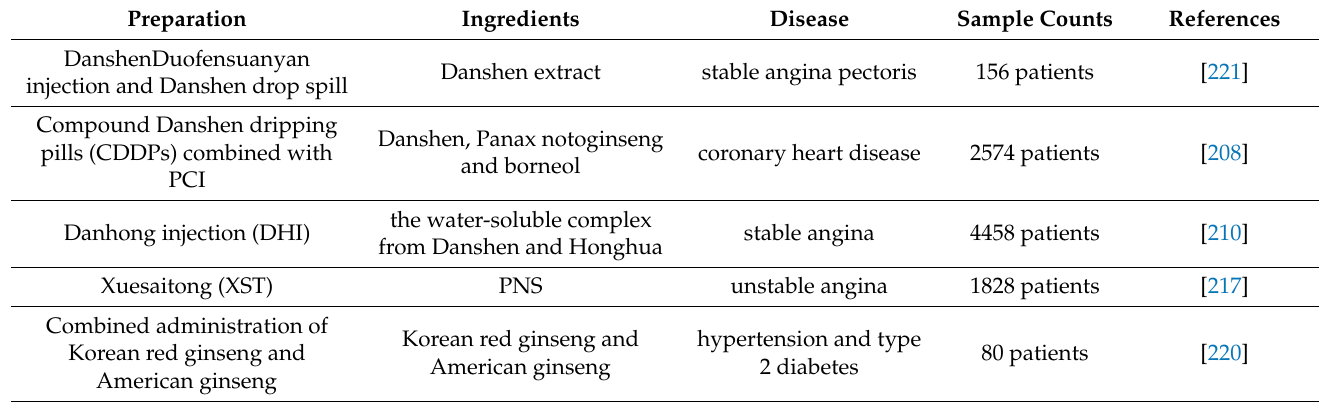
Table 4. Clinical applications of antioxidant treatment with medicinal